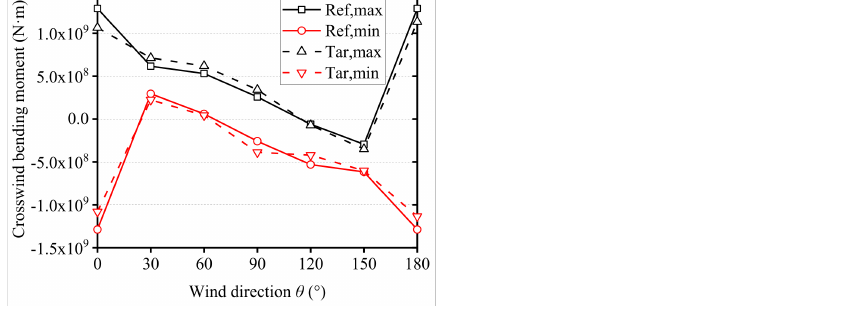
Figure 11. Crosswind moments of the target and reference models for different wind